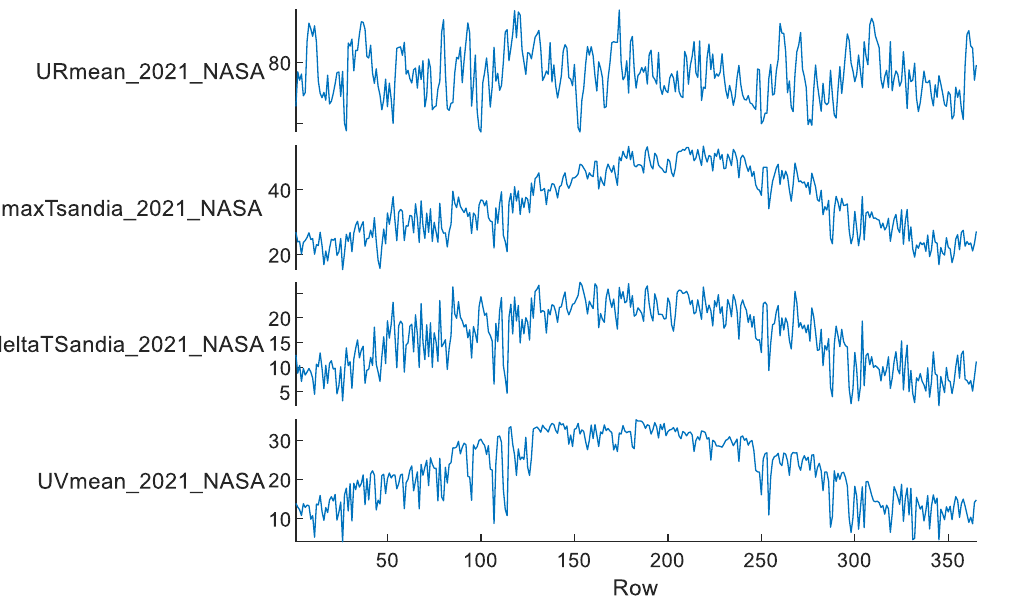
Figure 5. Onshore weather input data, 2021. From top to bottom: RH daily (%), T max (°C) ∆T daily (°C), UV daily ( W/m 2 ).